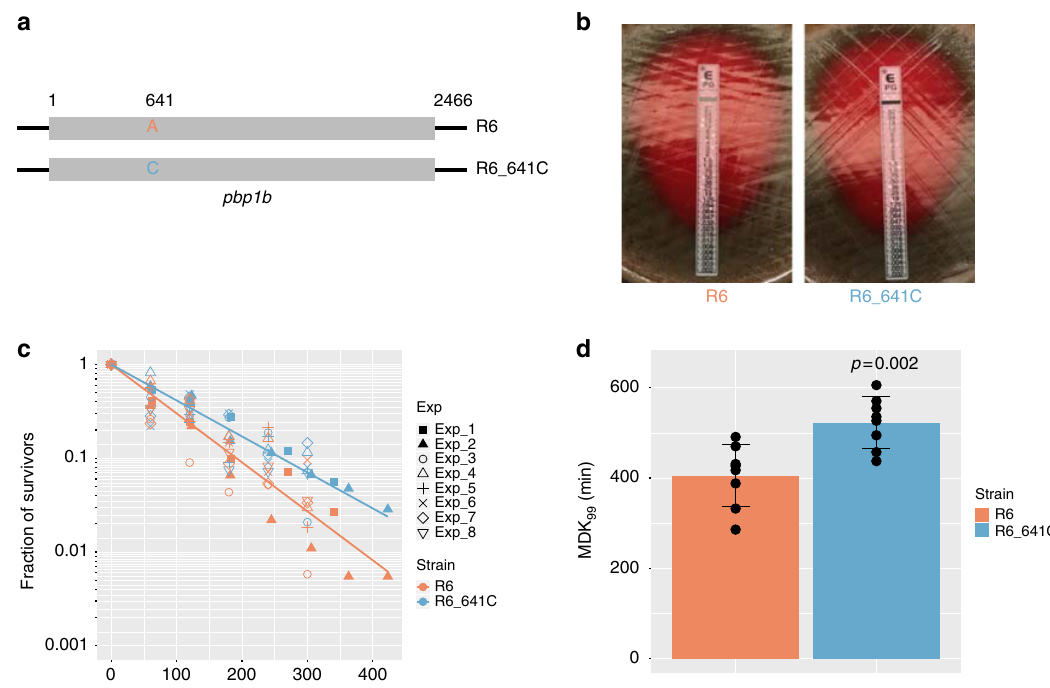
Fig. 4 Effects of pbp1b A641C on antibiotic resistance and tolerance in isogenic strains. a The pbp1b locus in the R6 strain was replaced by an allele carrying the pbp1b A641C point mutation to construct the R6_641C strain. b MIC test carried out using the penicillin E-test strip. c Survival of the isogeneic R6 and R6_641C strains in the presence of 3 μ g ml -1 penicillin (> 100-fold MIC). Data from eight independent experiments (Exp_1 to Exp_8) are shown. d Minimum duration for killing 99% of bacterial cells in the population (MDK 99 ) estimated from the survival curves. Data are shown as mean ± SD from the eight experiments in c . Dot plots are overlaid in the bar charts to show MDK 99 estimation from individual experiments. The P -value is based on a two-sample